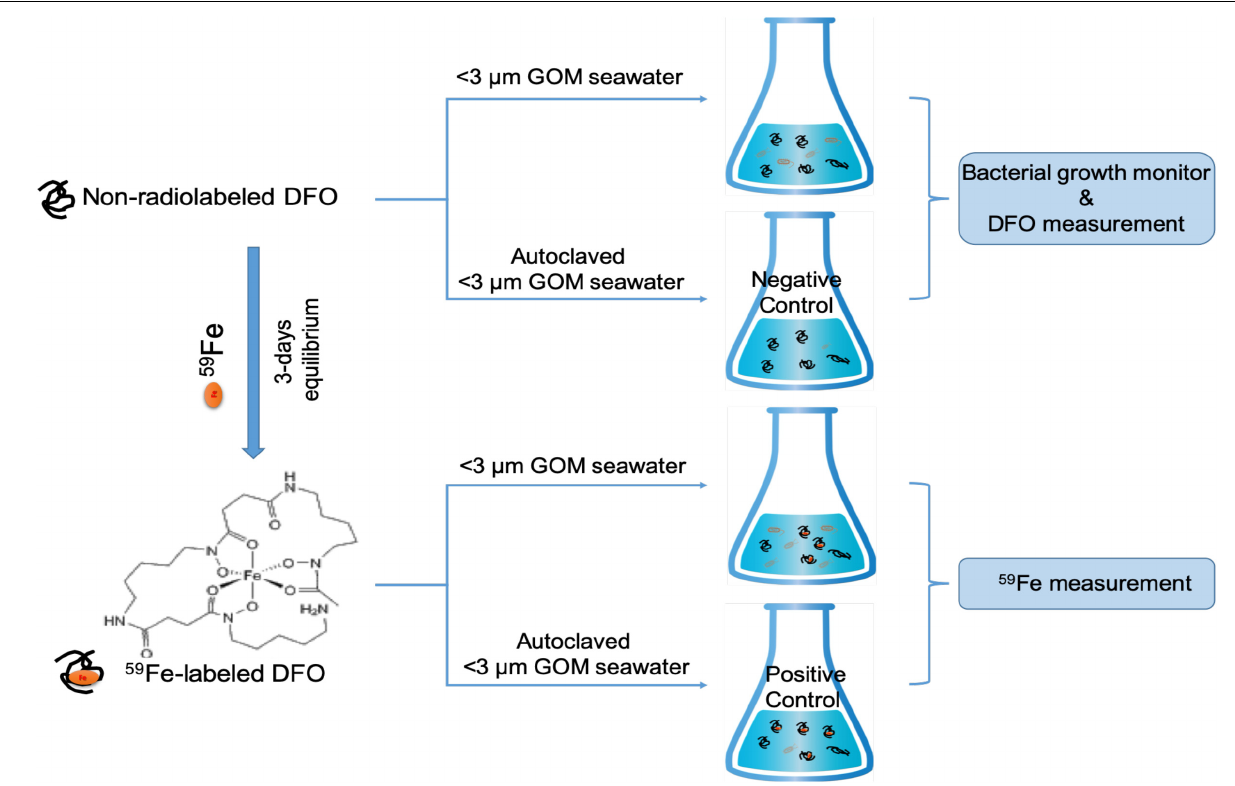
FIGURE 1 | Brief procedure schematic for the incubation of Fe-DFO complex in northern Gulf of Mexico seawater. < 3 µ m GOM seawater and autoclaved < 3 µ m GOM seawater [i.e., “negative” control (without 59 Fe) and “positive” control (with 59 Fe)] are both amended with carbon, nitrogen, and phosphorus sources in a Redfield ratio (i.e., 70.76 µ M glucose, 64 µ M NH 4 Cl, and 3.6 µ M NaH 2 PO 4